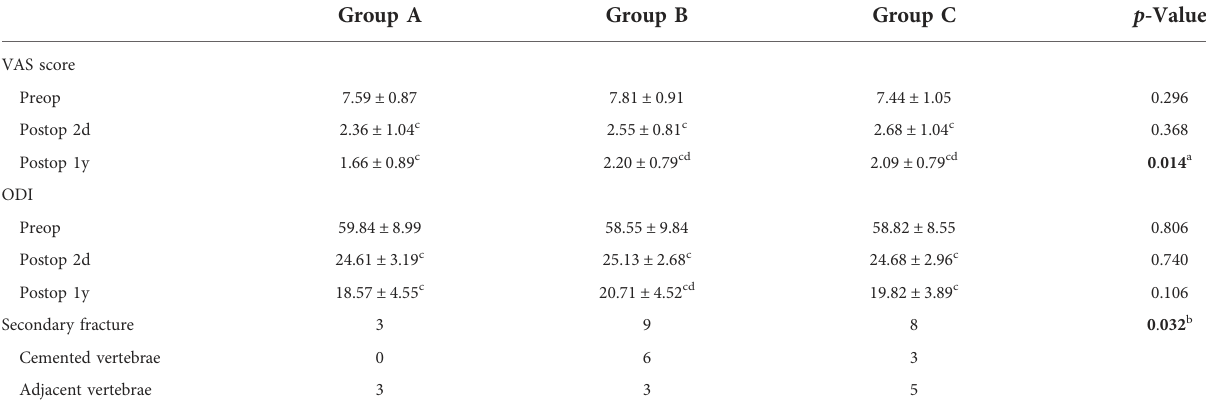
TABLE 3 Comparison of functional outcomes.